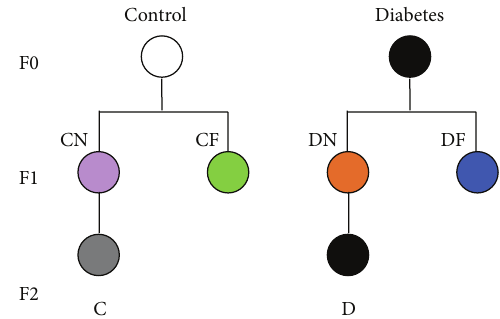
Figure 1: GDM rat model with moderate hyperglycemia induced by streptozotocin. Study design: female offspring were fed either normal or high-fat diets after weaning: control groups were fed normal diet (F1-CN) or high-fat diet (F1-CF) and rats in the diabetic group were fed normal diet (F1-DN) or high-fat diet (F1-DF). Adult females of the F1-CN and F1-DN groups were mated with control malestoobtainF2femaleoffspring(F2-CandF2-D).Purpledenotes theF1-CNgroup;green,F1-DN;orange,F1-CF;blue,F1-DF;andgrey, F2-C group; and the plain circle denotes the F2-D